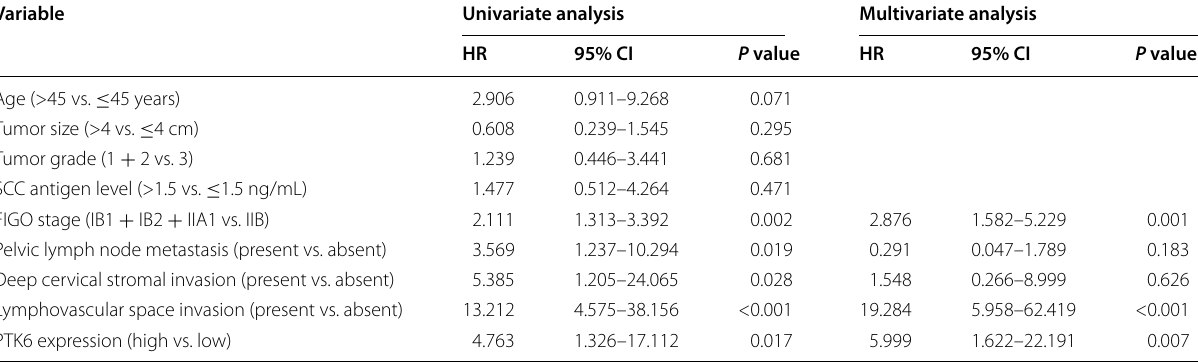
Table 2 Univariate and multivariate Cox regression analyses of clinicopathologic variables of patients with early-stage cervical squamous cell cancer for overall